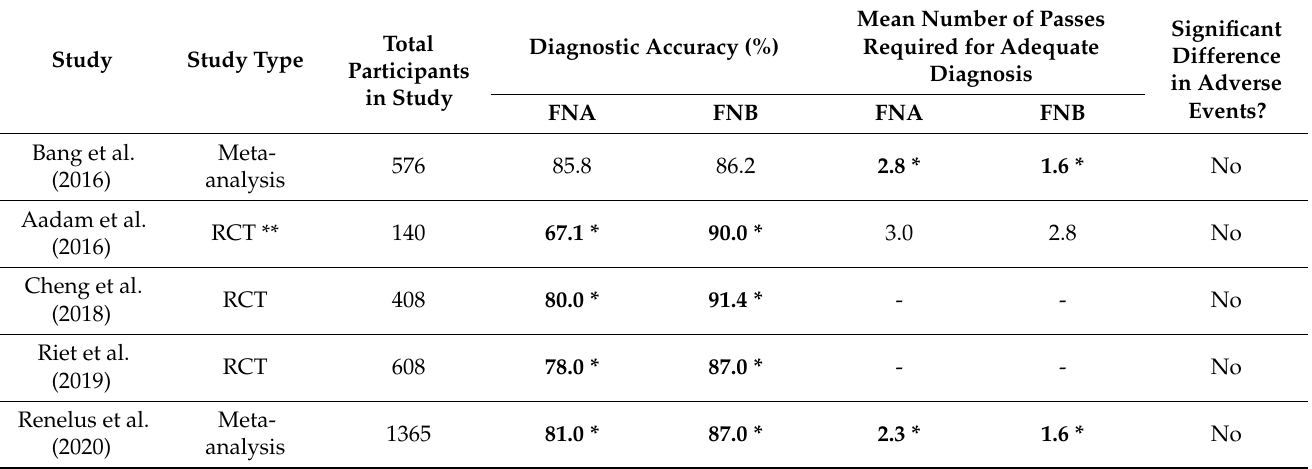
Table 1. Outcomes of EUS-guided FNA vs. fine needle biopsy